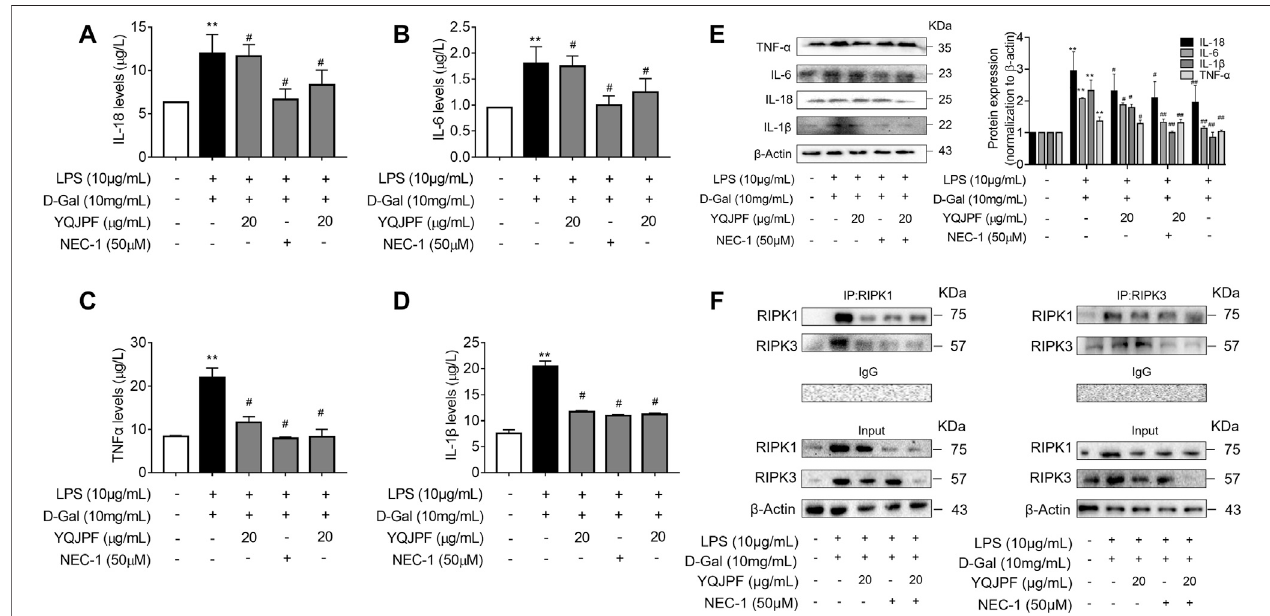
FIGURE8| YQJPF inhibited hepatocytenecroptosis inRIPK1-dependentmanner invitro .Human LO2cellsweretreatedwithLPS+D-Galfor 4 hand furtherpre- treated with 50 μ M Nec-1 for 1 h, followed by YQJPF or atractylone treatment for 24 h. (A – D) Expression levels of IL-1 β , IL-6, TNF- α , and IL-18 in LO2 cells were detected by ELISA. (E) Western blot and quantitative analysis of IL-1 β , IL-6, TNF- α , and IL-18. (F) RIPK1 was immunoprecipitated with its antibody and resulted in co- immunoprecipitation of RIPK3. Immunoprecipitation of RIPK3 with its antibody caused co-immunoprecipitation of RIPK1 in LO2 cells. Data are expressed as mean ± SD ( n (cid:2) 3). *vs. control group, # vs. LPS + D-Gal group; * p < 0.05, ** p < 0.01; # p < 0.05, ## p <